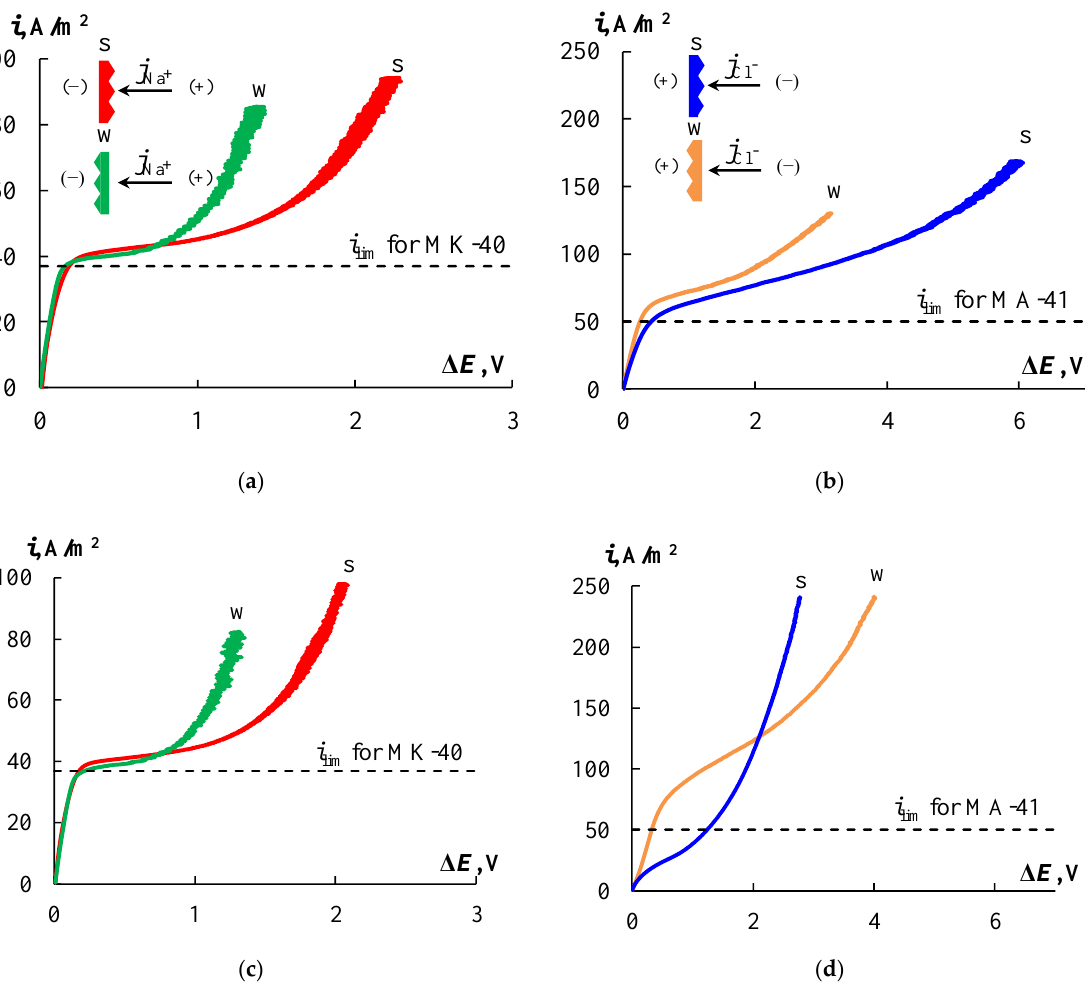
Figure 15. The CVCs of the profiled ( a , b ) and profiled with MF-4SK layers ( c , d ) MK-40 ( a , c ) and MA-41 membranes ( b , d ) in a 0.05 M NaCl solution with different membrane orientations to the flow of counter-ions indicated by the mark “ s ” and “ w ” . The dashed line shows the limiting current density for the initial membranes.